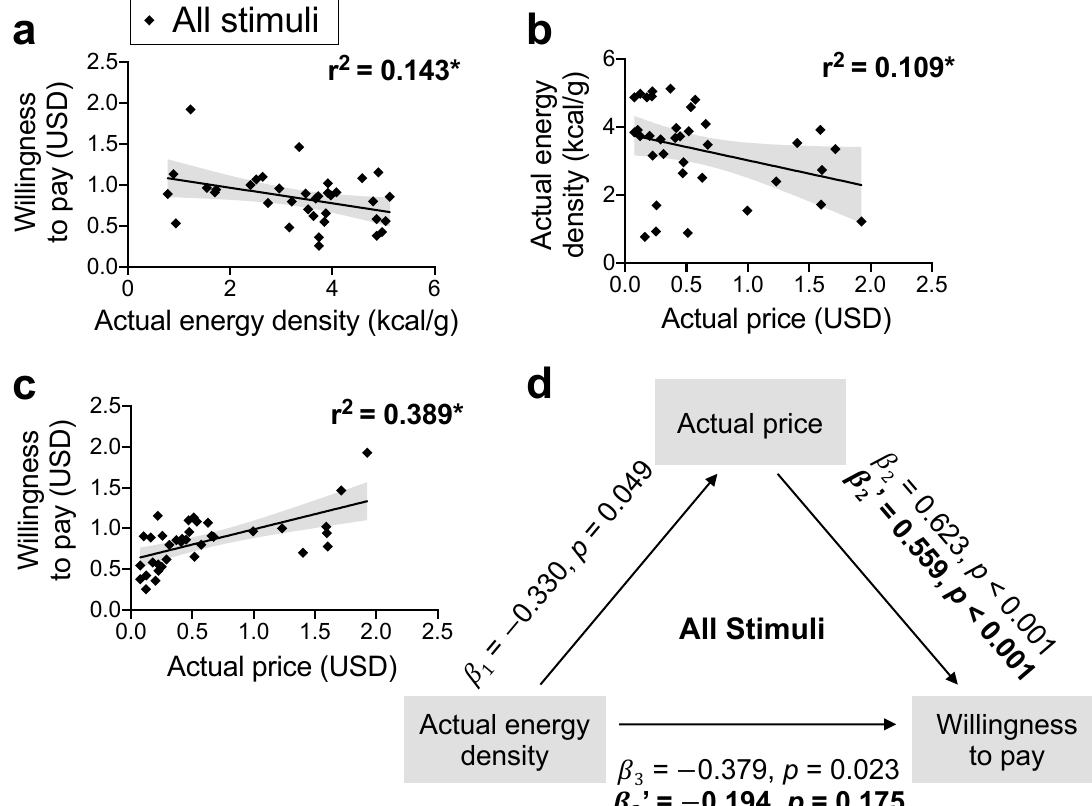
Figure 7. Food price mediates the negative association between WTP and actual energy density when portion size is varied. ( a , b ) Actual energy density was negatively related to WTP and actual price for foods pictured in varying portions (40, 120, or 200 kcal). ( c ) Actual price was also positively associated with WTP. ( d ) As the standardized betas ( β 1 , β 2 , β 3 ) for the separate regressions between energy density, price, and WTP were each significant, we tested whether price mediates the negative association between energy density and WTP. As predicted, the relationship between energy density and WTP ( β 3 (cid:48) ) was no longer significant when the indirect effect of price was accounted for in the regression model, which itself remained significant ( β 2 (cid:48) ) . Resulting r 2 values are shown for each regression performed on all food items (averaged across all participants). Each data point depicts a single food item and shading indicates 95% CI. * p <